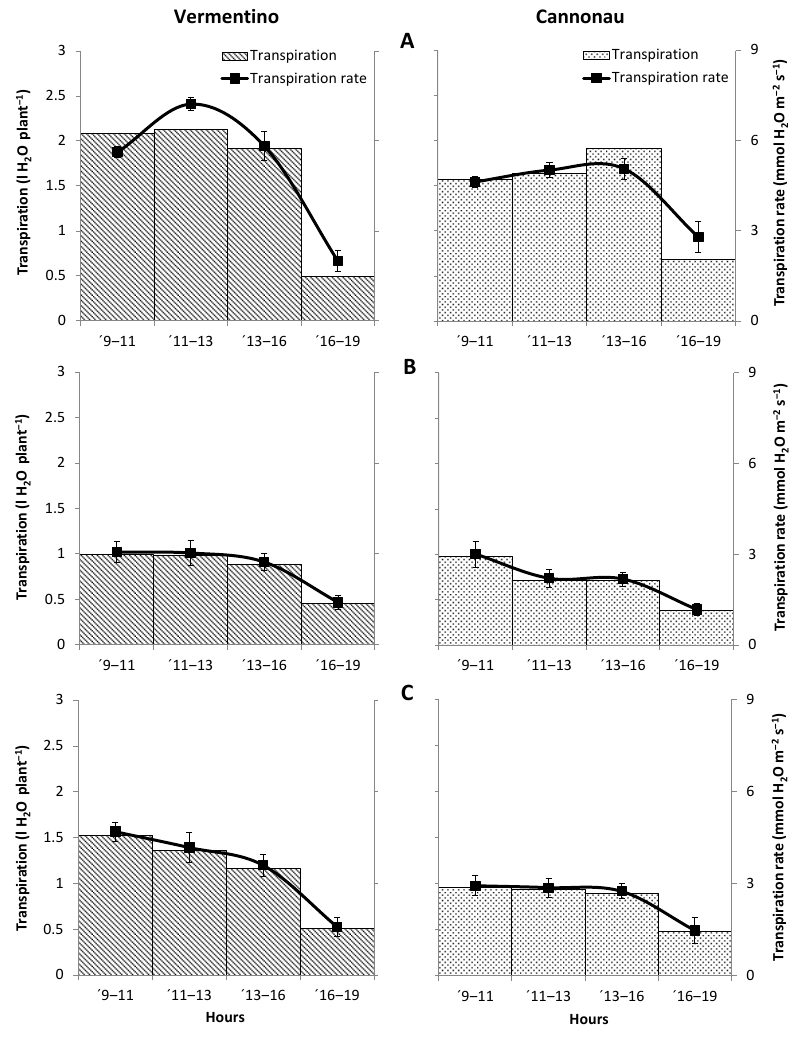
Figure A1. Daily transpiration volume per plant and transpiration rate over a sunny day at BBCH stages 71 ( A ), 83 ( B ) and 85 ( C ) in Vermentino (left) and Cannonau (right), at the Romangia site, during season 2019. Values are the mean ± standard